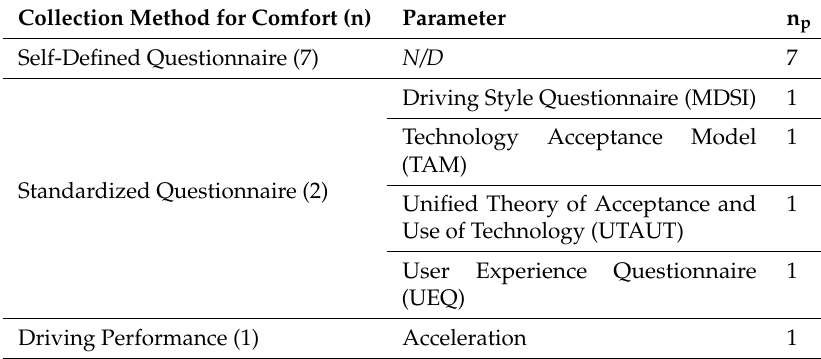
Table 13. Comfort collection methods and